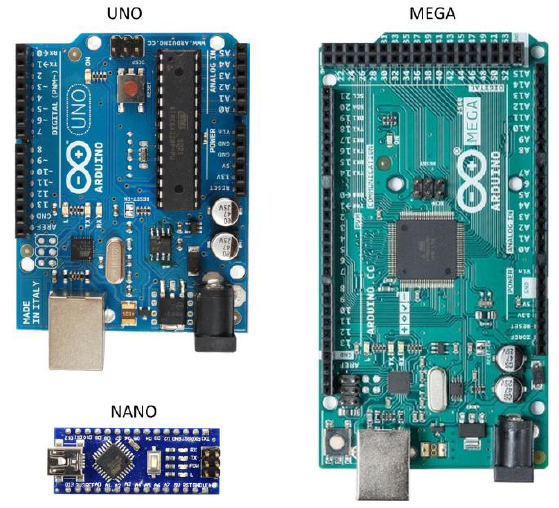
Fig. 1. Examples of Arduino computers (boards)